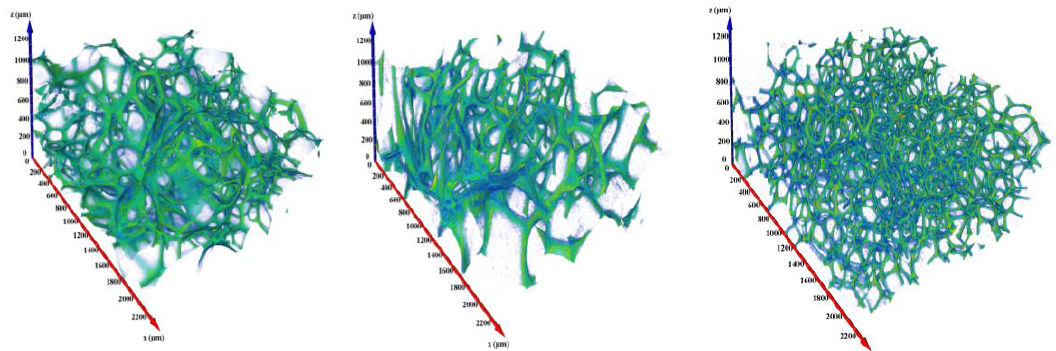
Figure 2. Three-dimensional Structures of the tannin foams (rendered volume ~5 mm 3 ): standard, nitric acid and pentane (left to right).